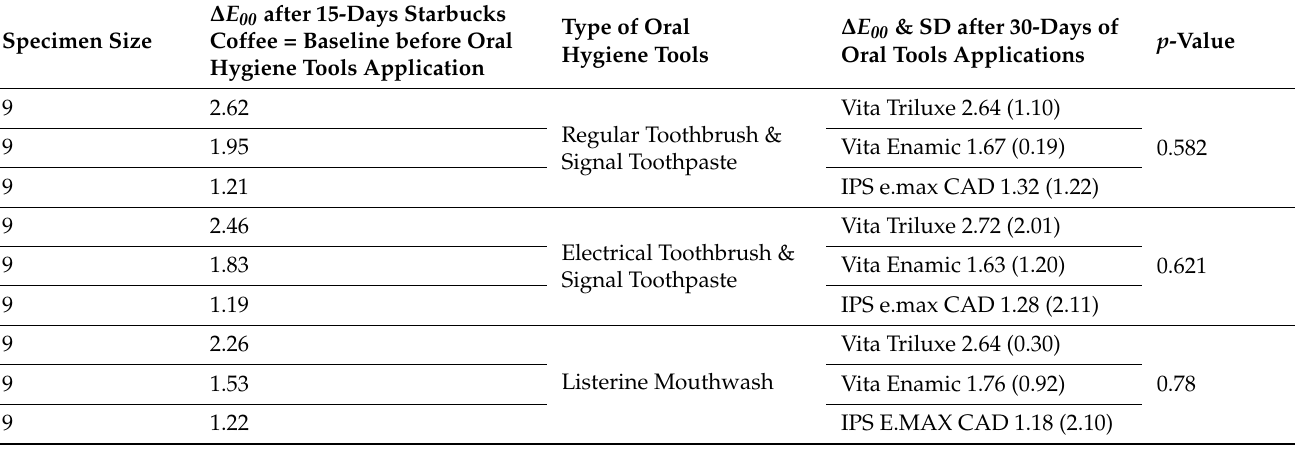
Table 1. Mean color change ( ∆ E 00 ) values at baseline and after 30 –days of cleaning with different oral hygiene tools and ceramic materials ( n =